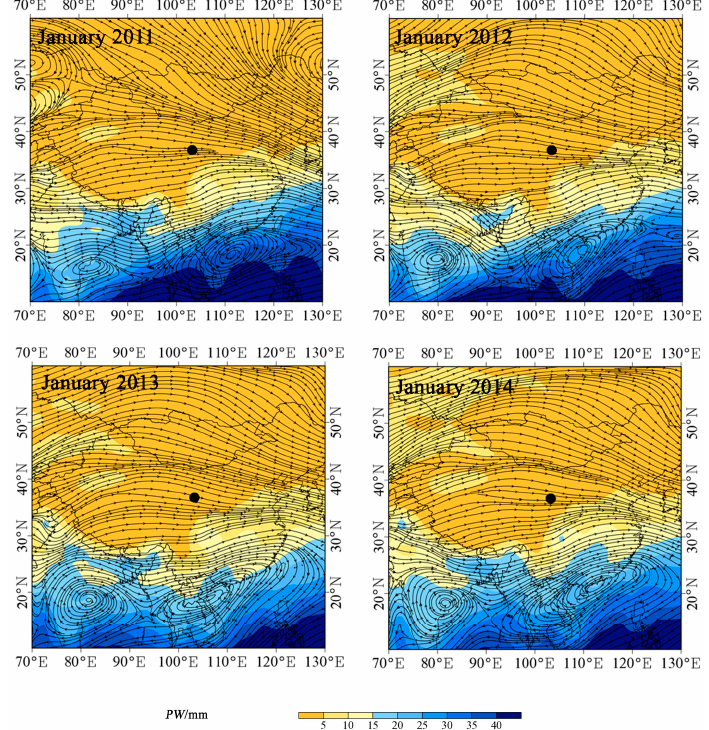
Figure 6. Water vapor stream and precipitable water amount ( PW ) surrounding the study region in January for different years.